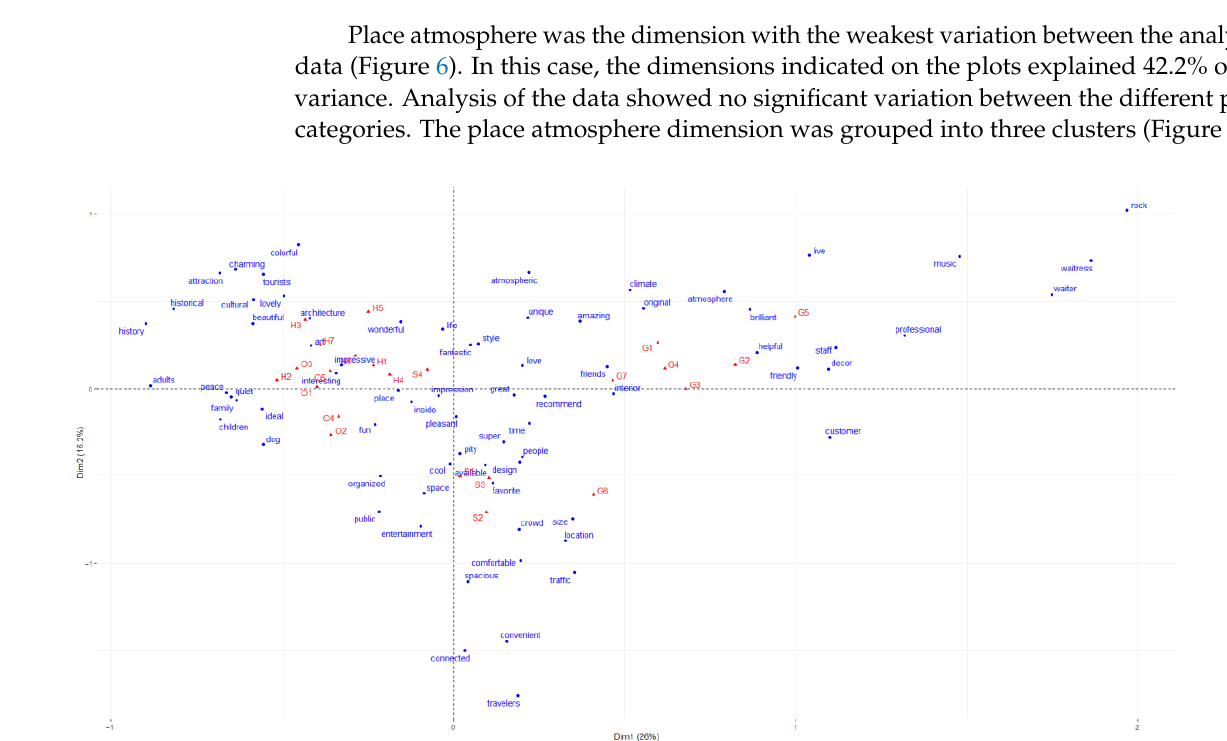
Figure 6. Correspondence analysis of terms associated with place atmosphere dimension and places selected for the study. Red labels represent analyzed places. Blue labels represent keywords associated with shown at the figure place experience dimension. The x -axis and y -axis indicate percent of variance